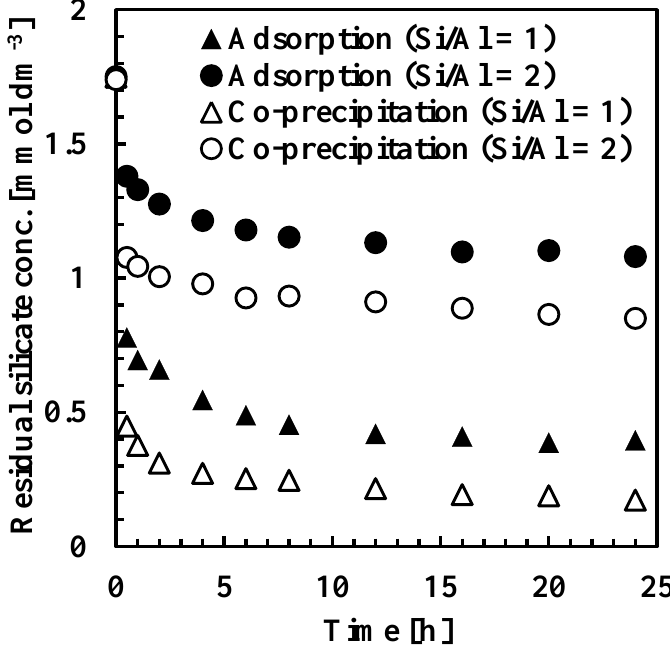
Figure 7. Residual silicate concentration in co-precipitation and adsorption experiments